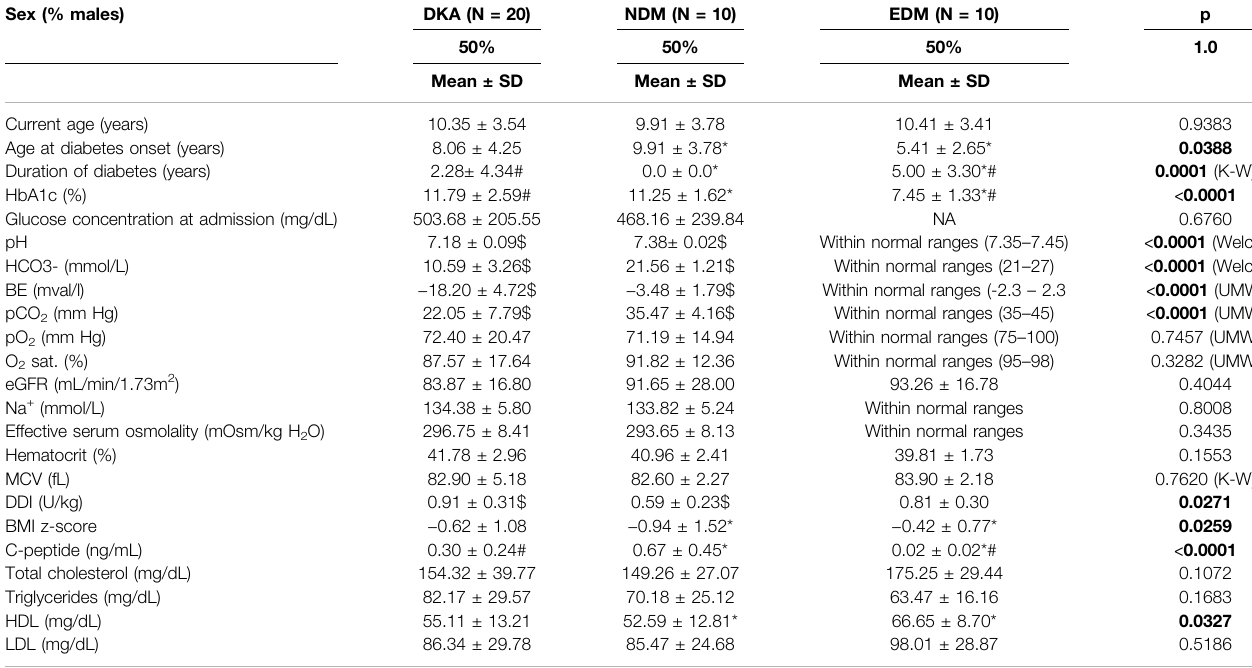
TABLE 2 | Study groups ’ characteristics selected for metabolomics fi ngerprinting of the past HG episode. Sex (%